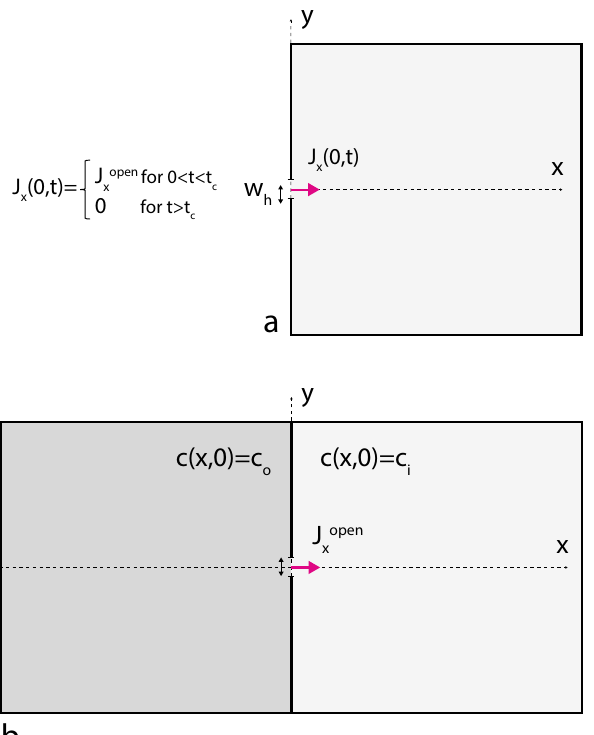
Figure 1. Box model for a cell containing a transient plasma membrane hole. Model in ( a ) shows the full model t c . Model in ( b ) is a 2-box model for the cell exterior/interior with an always- including hole closure at time t = open open hole, used for determining the time-dependent influx J x ( t ) through the